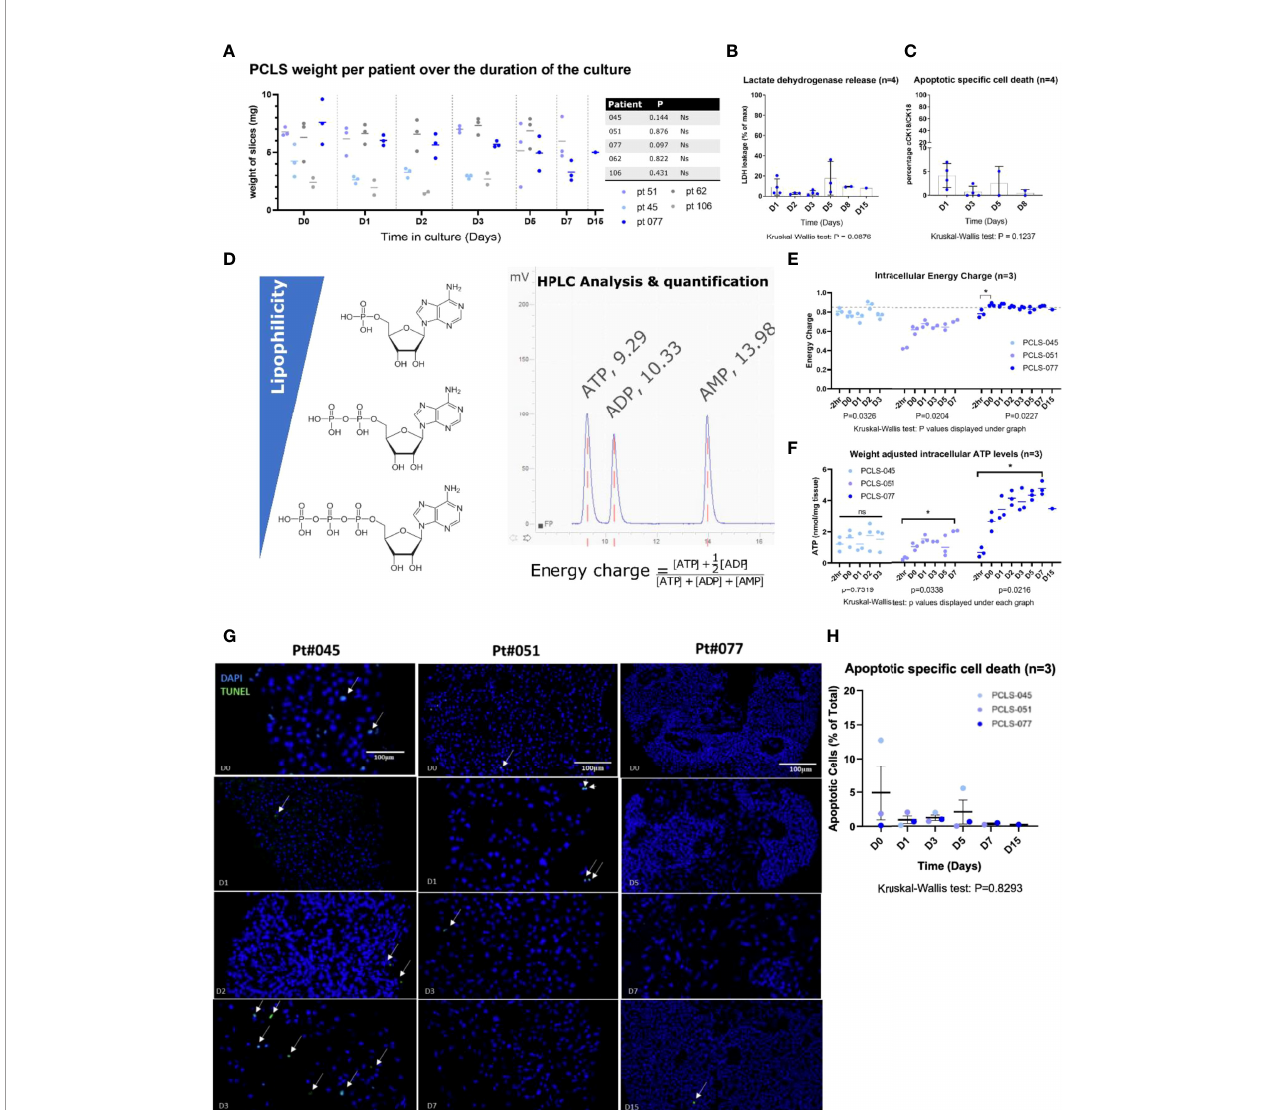
FIGURE 2 | LM-NEN PCTS cultured in carbogen are viable for up to 15 days. (A) Tissue integrity was evaluated by measuring the slice weight over the duration of the culture period (at day 0, 1, 2, 3, 5, 7 & 15). Each point represents the weight of a single slice. 3 replicates per patient per timepoint are displayed as mean ± SD. Ns, P>0.05. (B) Weight-adjusted LDH leakage in PCTS supernatant throughout the culture was plotted as a percentage of the total LDH present per mg of tissue (determined separately for each patient). (C) Caspase-cleaved cytokeratin 18 (cCK18) indicative of apoptotic speci fi c cell death is shown as a percentage of total cell death (full form cytokeratin 18, CK18). Datapoints in (B, C) represent individual patients and are an average of 3 replicates per patient. Bars indicate mean ± SD of 4 patients (D0-D8) or 1 patient (D15). (D) Overview of HPLC quanti fi cation of ATP, ADP and AMP and formula utilised to calculate the energy charge. Retention times for ATP, ADP and AMP (consistent across all runs) are indicated in the graph. (E, F) Intracellular energy charge and weight adjusted intracellular ATP levels in LM- NEN PCTS at indicated timepoints for patients with viable tumour epithelium (045, 051 and 077). Each datapoint represents a single slice (*P ≤ 0.05). (G) Representative images showing apoptotic nuclei stained by TUNEL (green, indicated by white arrows) in tissue slices generated from 3 patients; 3 slices (D0-D7) or 1 slice (D15) were analysed per patient at each indicated timepoint. (H) TUNEL positive nuclei were quanit fi ed ans presented as %Apoptotic cells of total number of cells per image. Data are shown as mean ± SEM of 3 patients and each dot represents a single